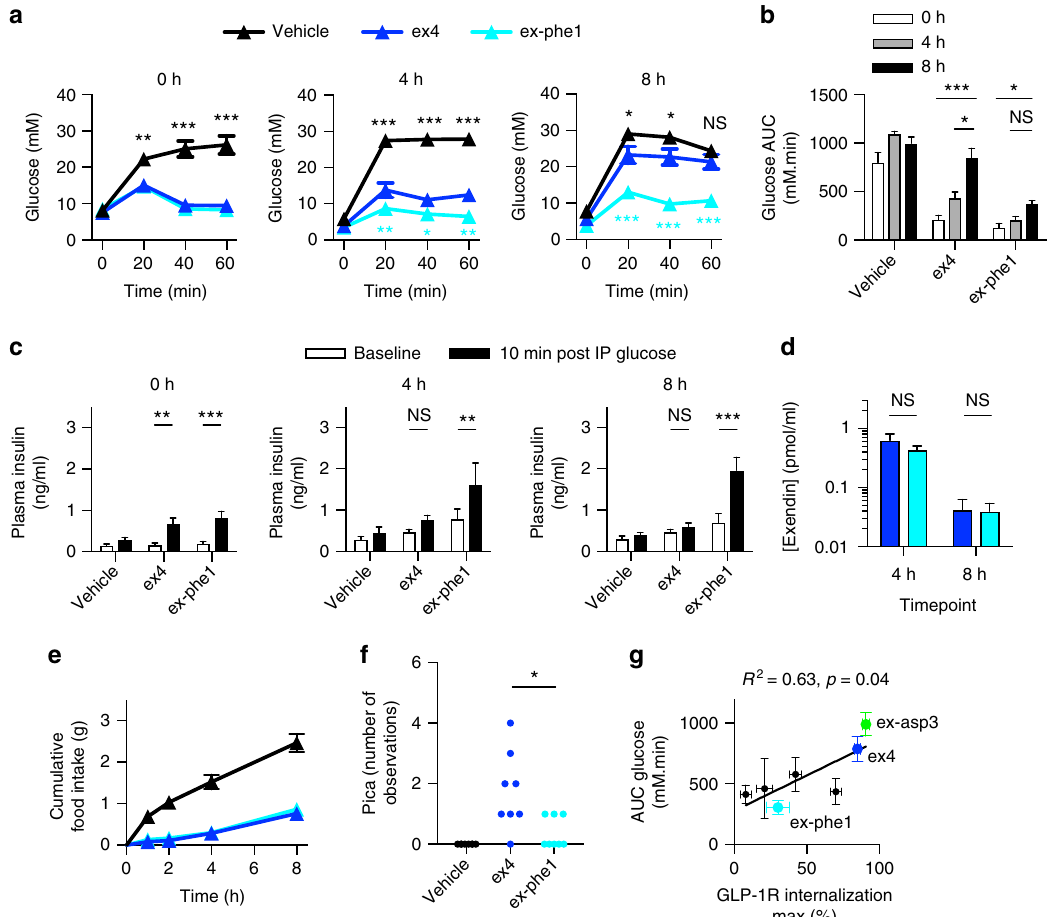
Fig. 8 Antidiabetic effects of exendin-phe1 in vivo. a Blood glucose during IPGTT (2 mg kg − 1 glucose) performed in HFHS mice at the indicated time-points after intraperitoneal (IP) injection of agonist (2.4 nmol kg − 1 ), n = 10/group except vehicle group at 4/8 h ( n = 9), two-way repeat measures ANOVA with Tukey ’ s test, with signi fi cance vs. exendin-4 shown. b AUC determined from a , relative to baseline glucose at t = 0, the two-way ANOVA with Dunnett ’ s test vs. 0 h. c Plasma insulin before and 10 min after IP administration of glucose (2 g kg − 1 ) in HFHS mice, at indicated time-point after IP injection of agonist (2.4 nmol kg − 1 ), n = 10/group except vehicle 0 h ( n = 8) and 4 h vehicle/exendin-4 ( n = 9), two-way repeat measures ANOVA with Sidak ’ s test. d Plasma drug level at indicated time-points after IP injection of agonist (24 nmol kg − 1 ), n = 4 per group, two-way repeat measures ANOVA with Sidak ’ s test. e Cumulative food intake in fasted HFHS mice after IP injection of agonist (2.4 nmol kg − 1 ), n = 8/group. f Observed pica behavior in fasted lean mice treated with IP agonist (2.4 nmol kg − 1 ), n = 8/group, Mann – Whitney test comparing exendin-4 vs. exendin-phe1. g Relationship between agonist-induced GLP-1R internalization ef fi cacy (Supplementary Fig. 1) and glucose lowering during IPGTT (Supplementary Fig. 10g), assessed as AUC relative to glucose at t = 0, relationship quanti fi ed by linear regression. * p < 0.05, ** p < 0.01, *** p < 0.001, by statistical test indicated above. Error bars